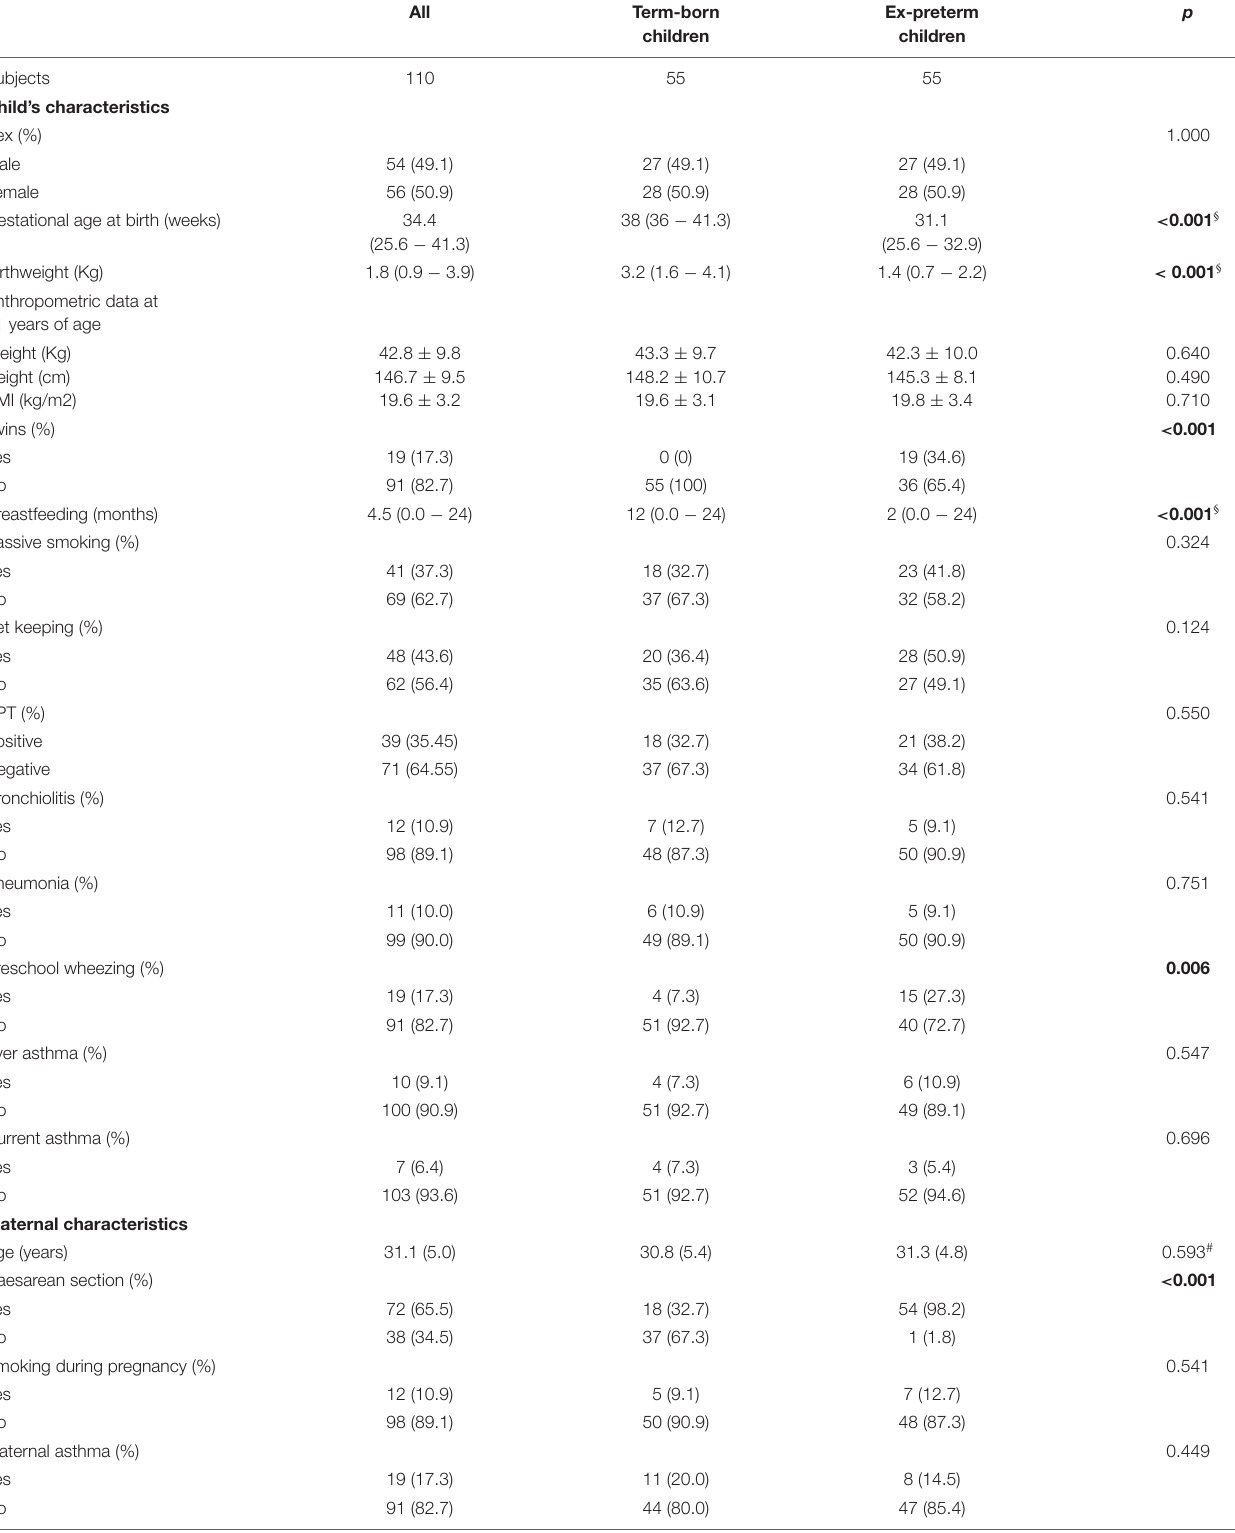
TABLE 1 | Characteristics of children and their